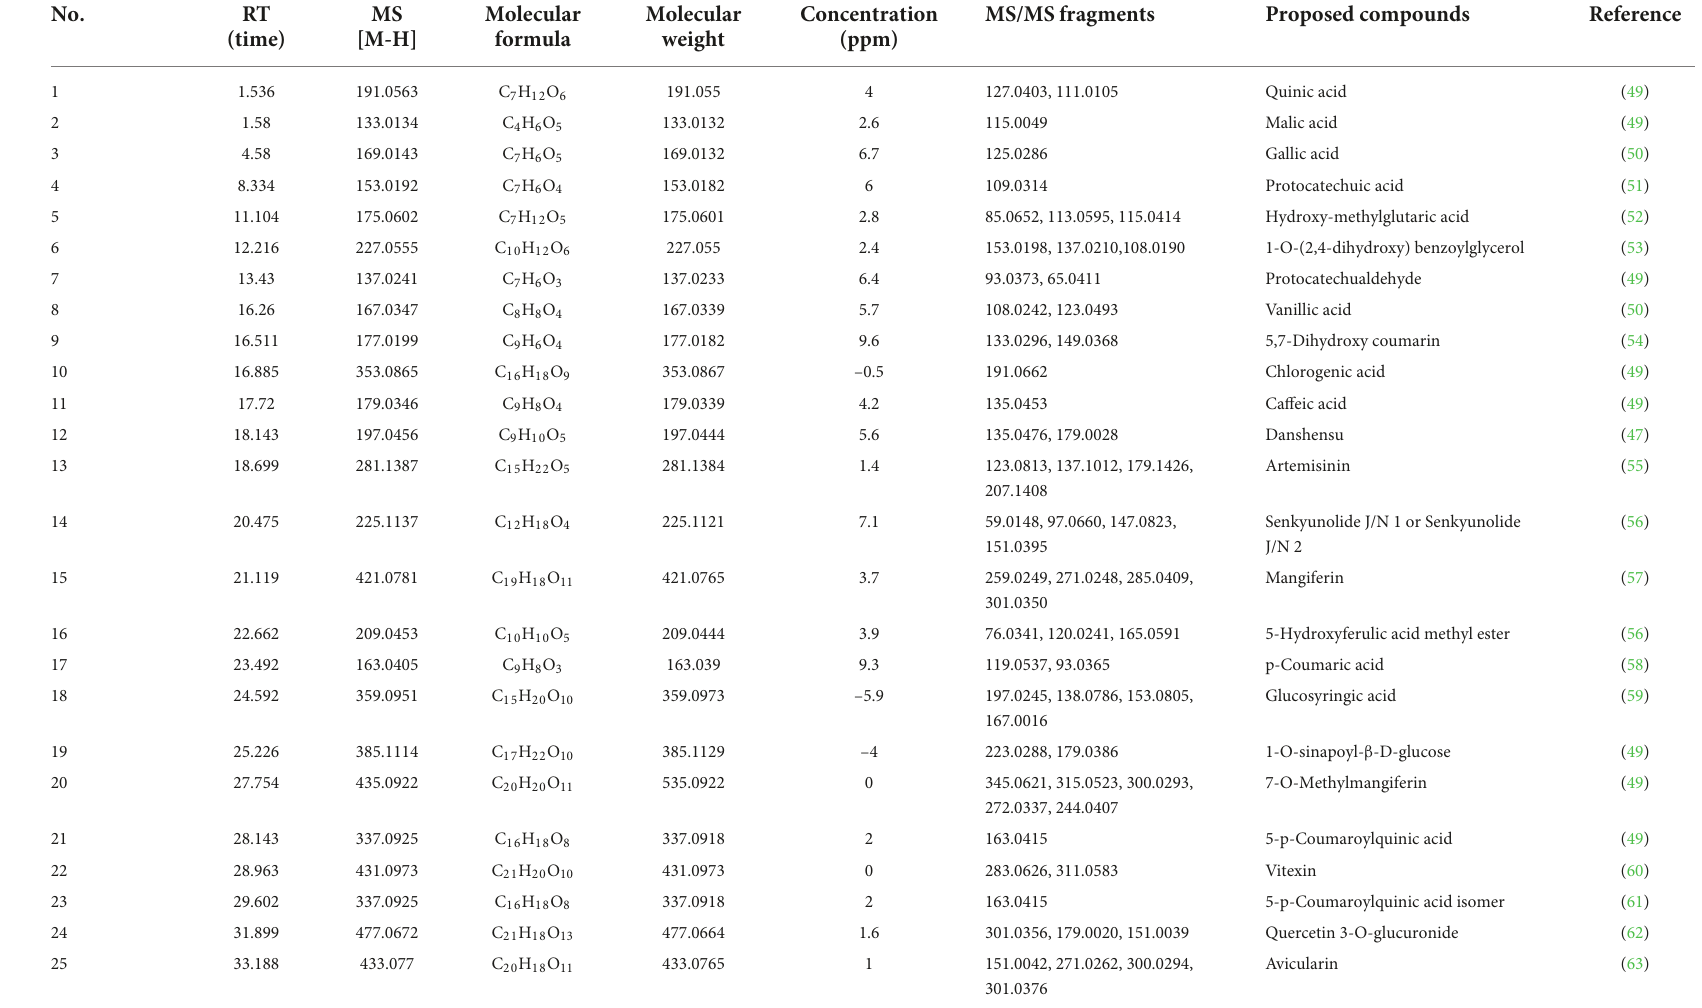
TABLE 3 The MS information of tentatively identified compounds from EtOAc fraction.